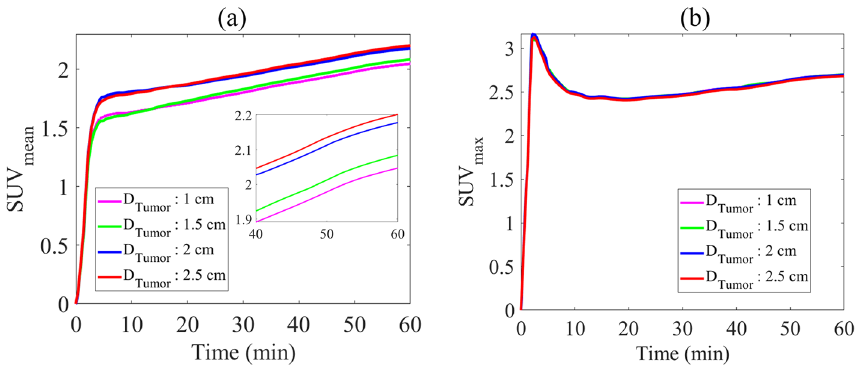
Figure 9. Time-radioactivity curves of different tumor sizes. ( a ) Mean and ( b ) maximum SUV across the tumor